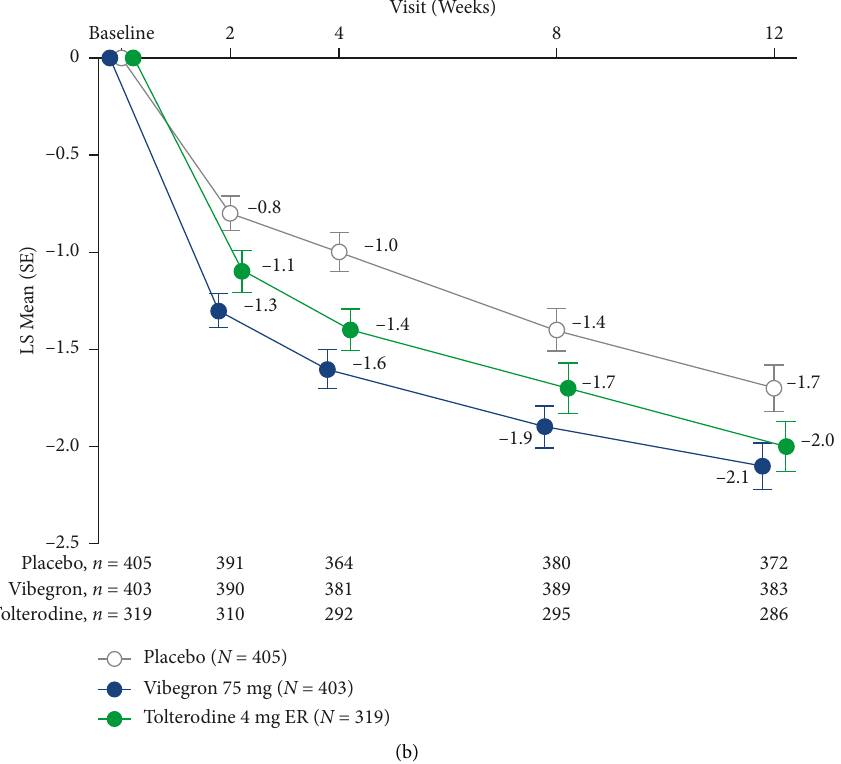
Figure 2: LS mean (SE) change from baseline in mean daily number of micturitions for patients with (a) OAB dry and (b) OAB wet. ER, extended release; LS, least squares.